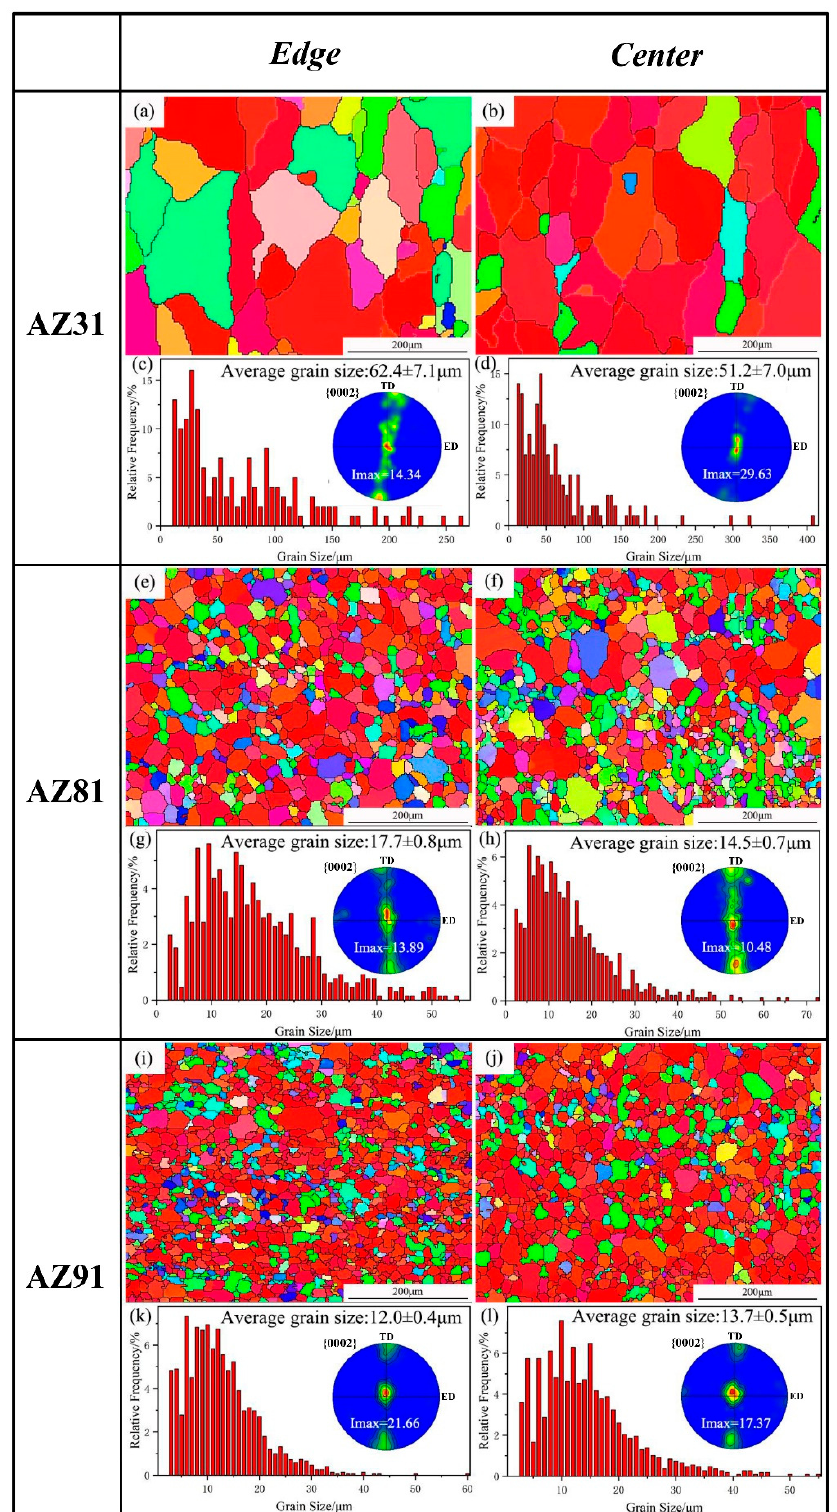
Figure 6. EBSD orientation maps, (0002) pole figure, grain size distribution and average grain size in edge and center of as-extruded three Mg alloy sheets: ( a , c ) The edge of AZ31; ( b , d ) The center of AZ31; ( e , g ) The edge of AZ81; ( f , h ) The center of AZ81; ( i , k ) The edge of AZ91; ( j , l ) The center of AZ91.